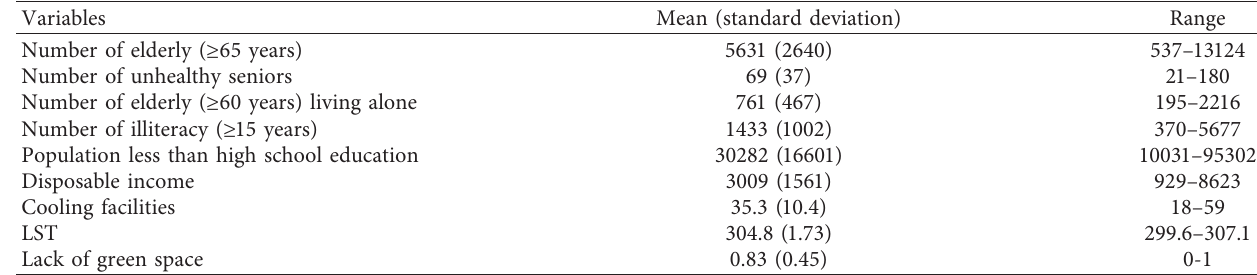
Table 2: Descriptive statistics for the vulnerability variables.